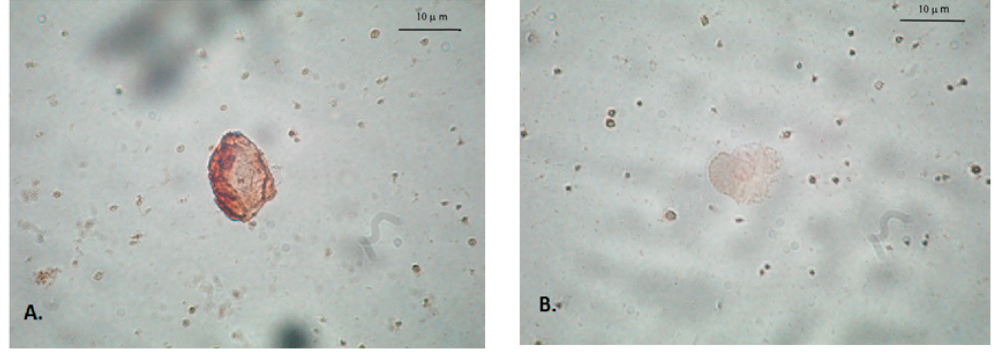
Figure 1. The expression of TNF- α in the monocytes of controls ( A ); and migraine patients ( B ).